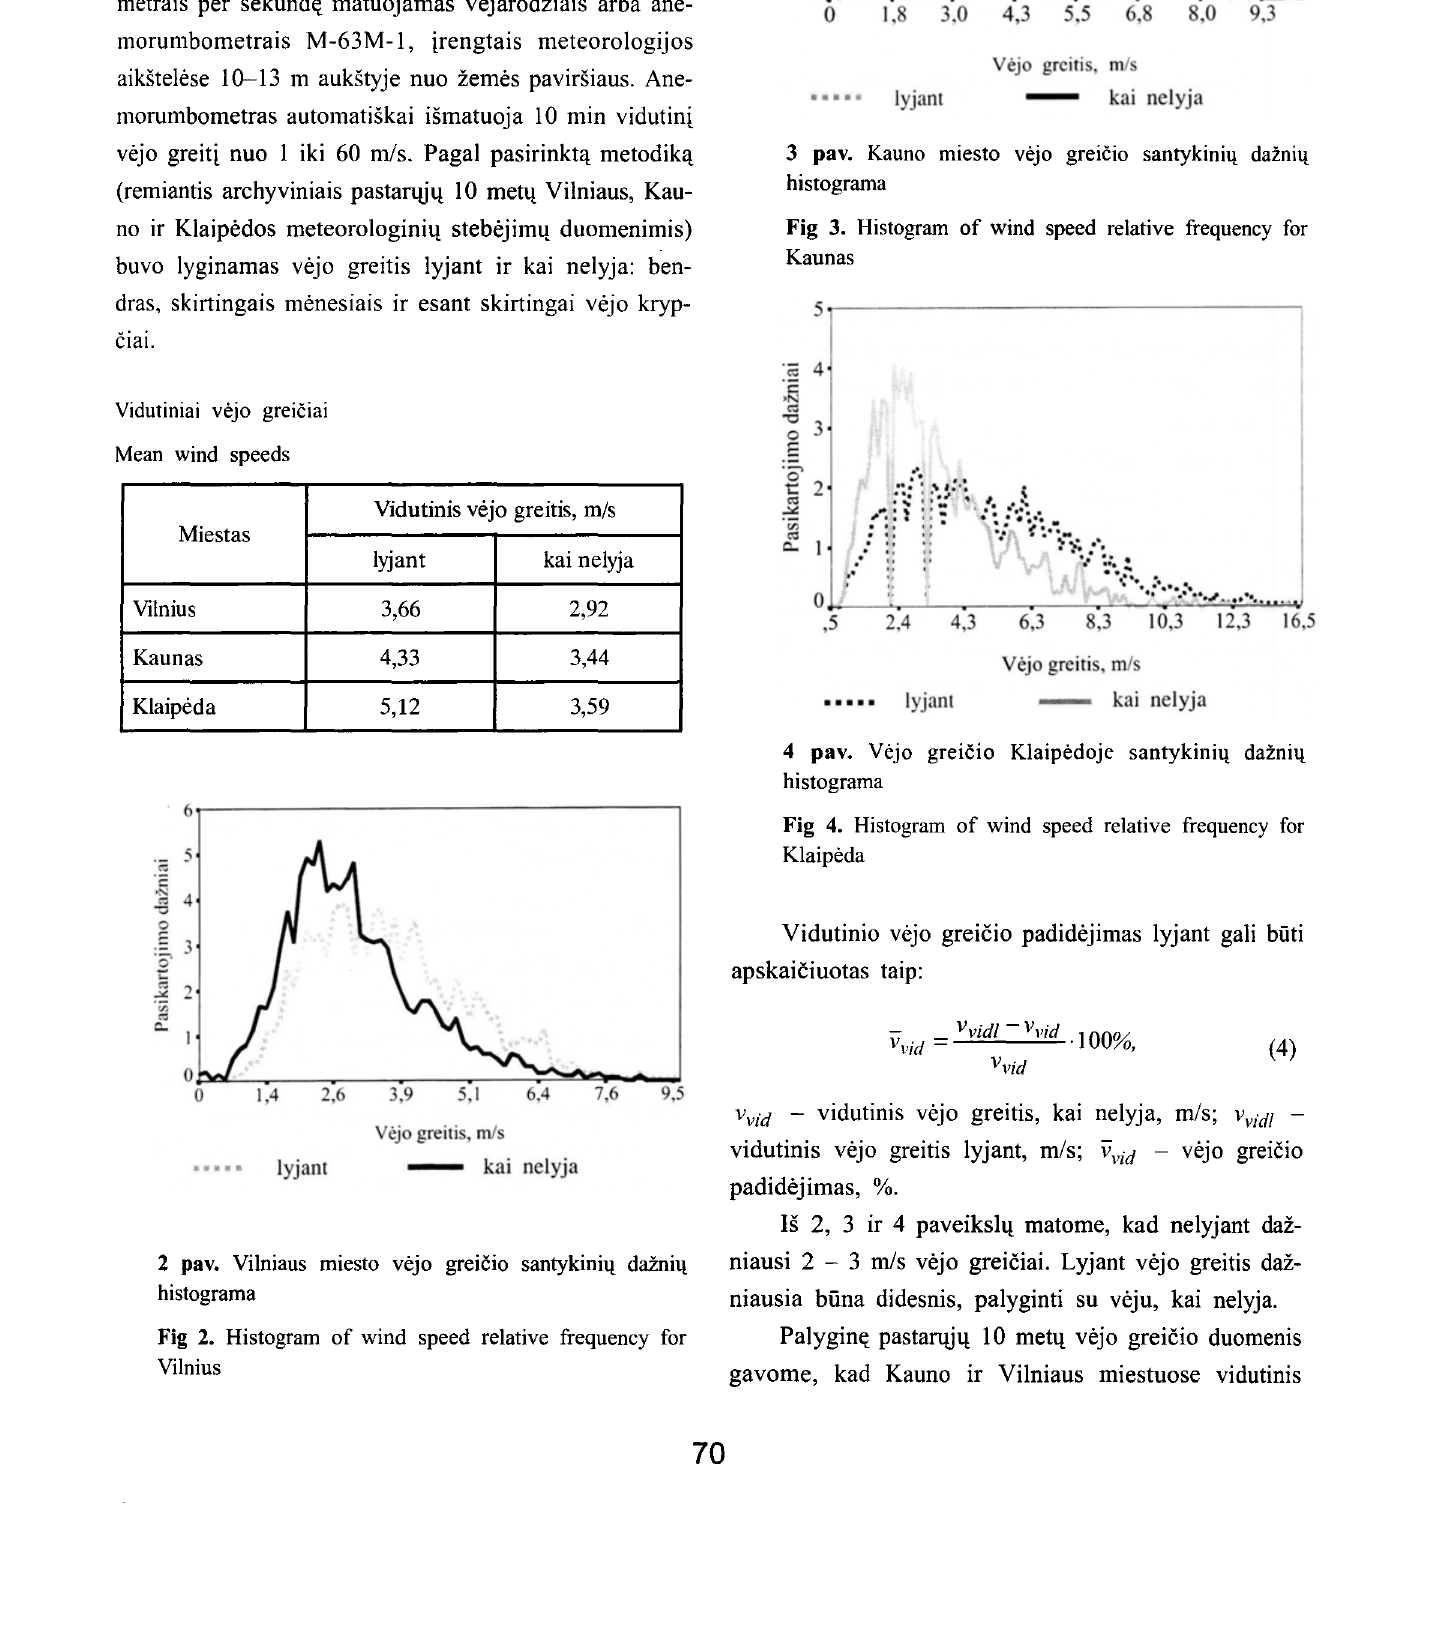
Fig 3. Histogram of wind speed relative frequency for Kaunas